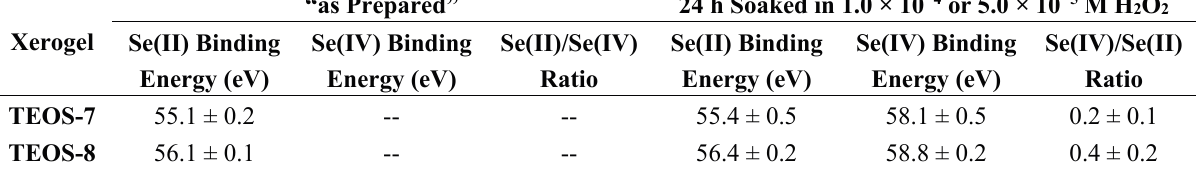
Table 4. The position and ratios of Se (II) and Se (IV) peaks calculated for TEOS-7 and TEOS-8 xerogels “as prepared” and after submersion in 1.0 × 10 − 4 M (for TEOS-7 ) and 5.0 × 10 − 5 M (for TEOS-8 ) H 2 O 2 in ASW for 24 h. The position and ratio values are the mean of five spectra recorded for each sample ± 1 SD. The peaks positions were referenced by setting a C 1s peak to 284.5